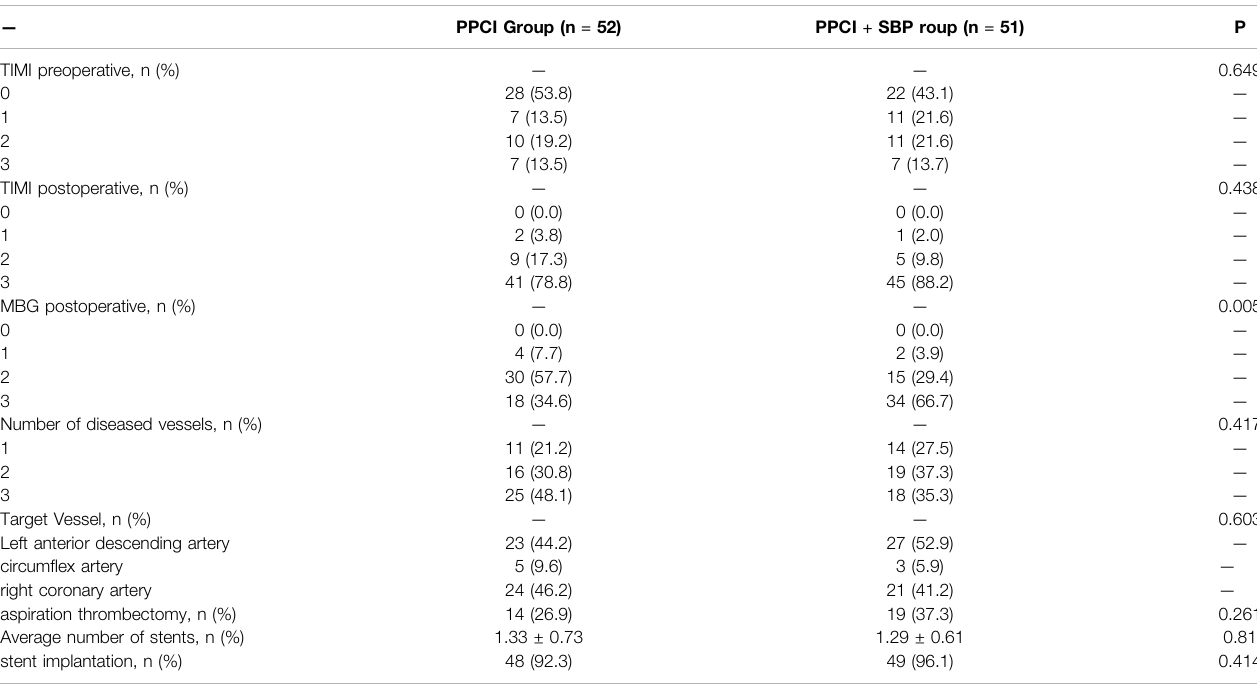
TABLE 3 | Comparison of intraoperative characteristics between PPCI + SBP and PPCI groups. — PPCI Group (n = 52) PPCI + SBP roup (n = 51) TIMI preoperative, n